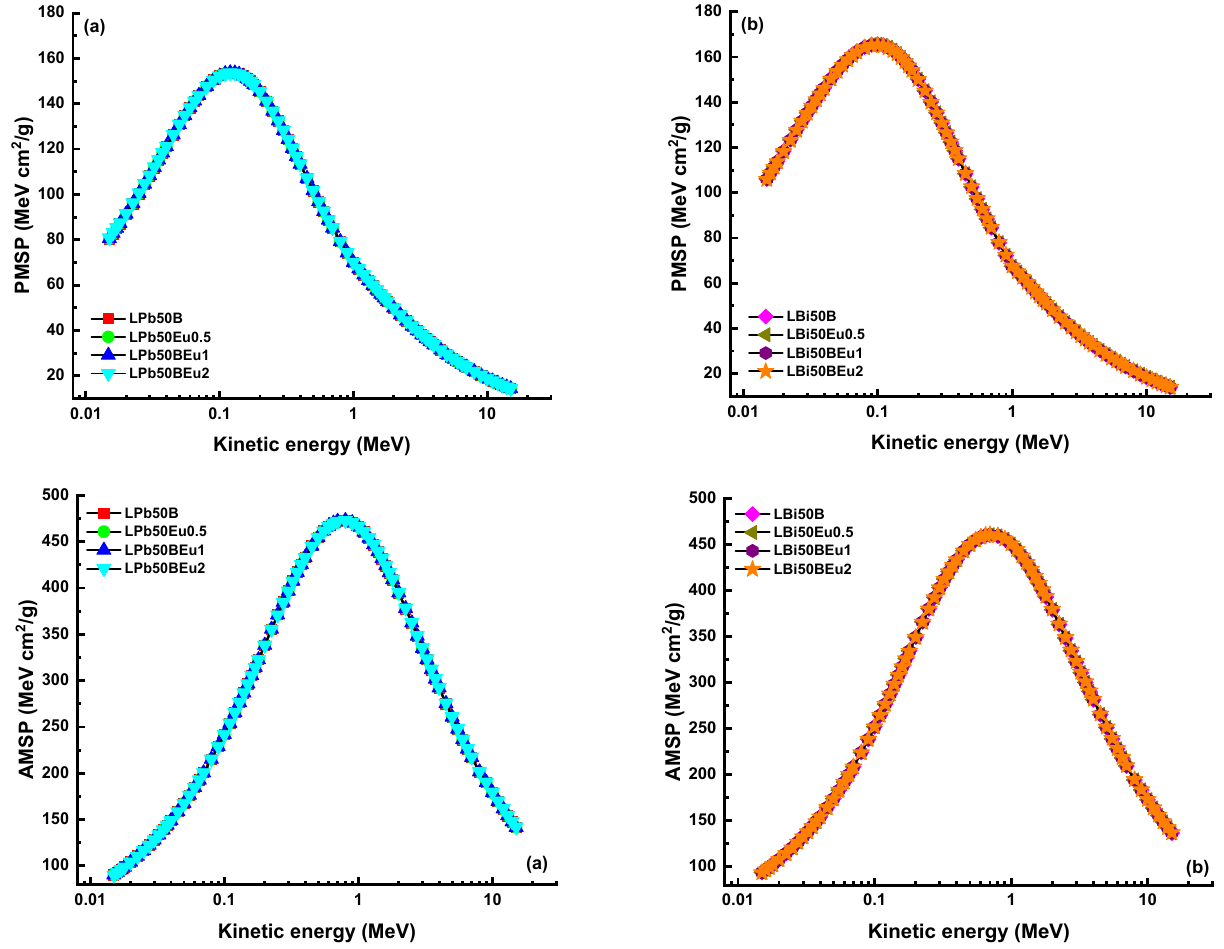
Figure 10. Proton (PMSP) and alpha (AMSP) mass stopping as a function of kinetic energy for ( a ) LPb50BEu and ( b ) LBi50BEu glasses.